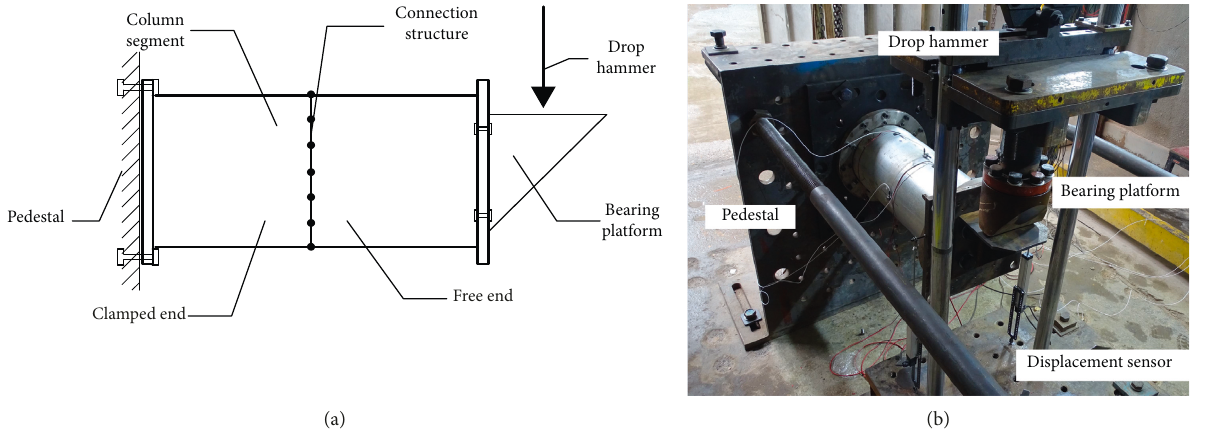
Figure 4: The schemata of the experimental loading and